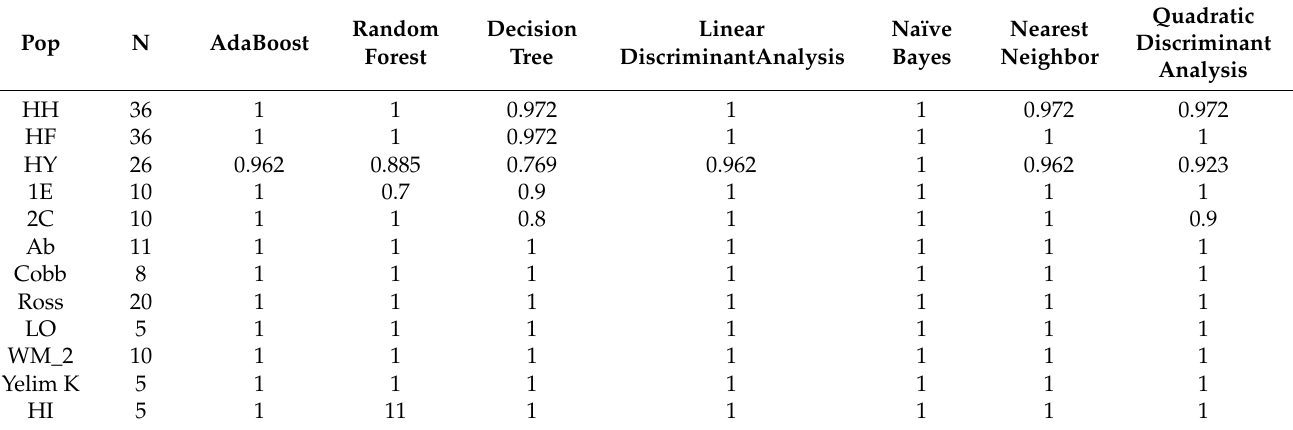
Table 3. Classification of validation samples, using the 36 selected SNP